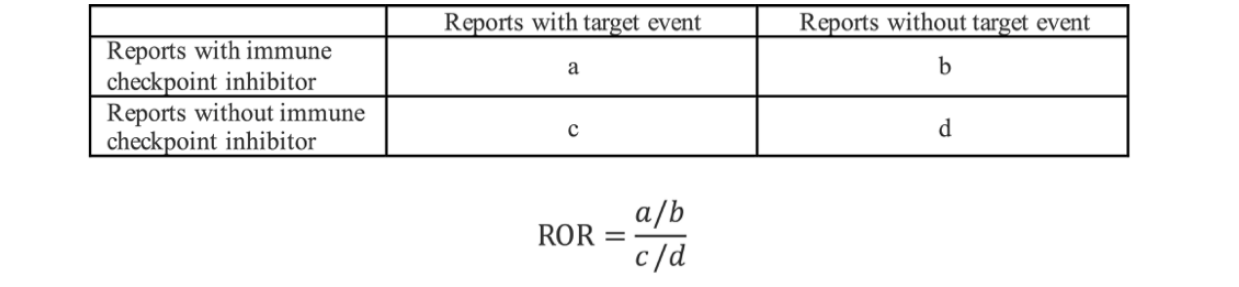
Figure 3. The contingency table and equation for the implementation of the reporting odds